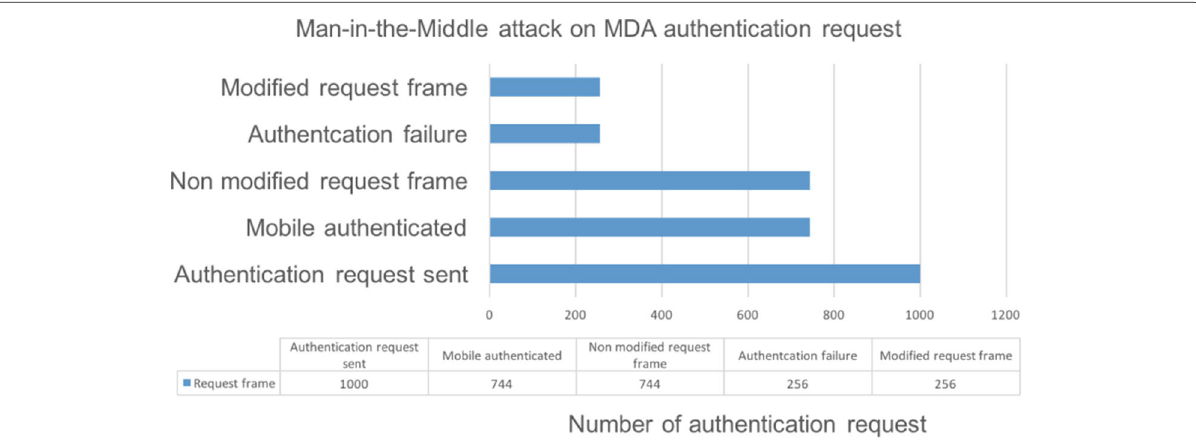
Fig. 5 Man-in-the-middle attack on MDA authentication